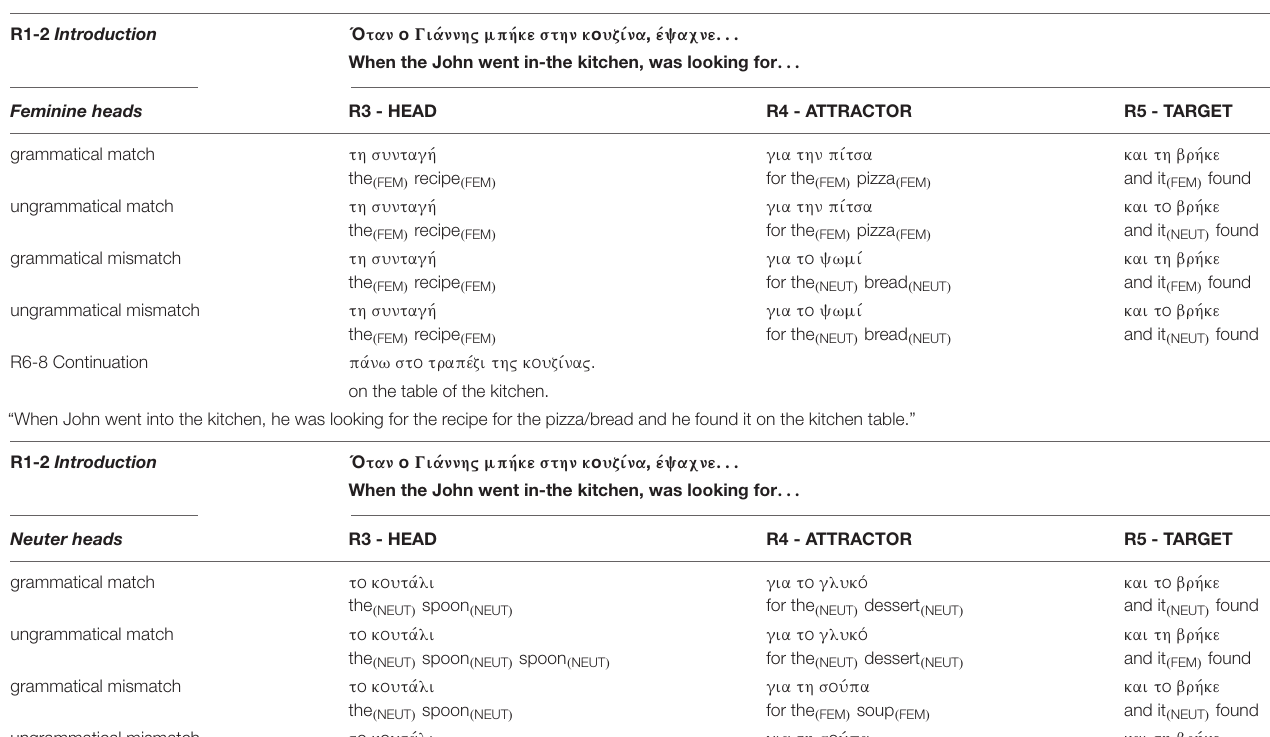
TABLE 3 | A complete item for feminine and neuter heads in Experiment 2. R stands for regions.